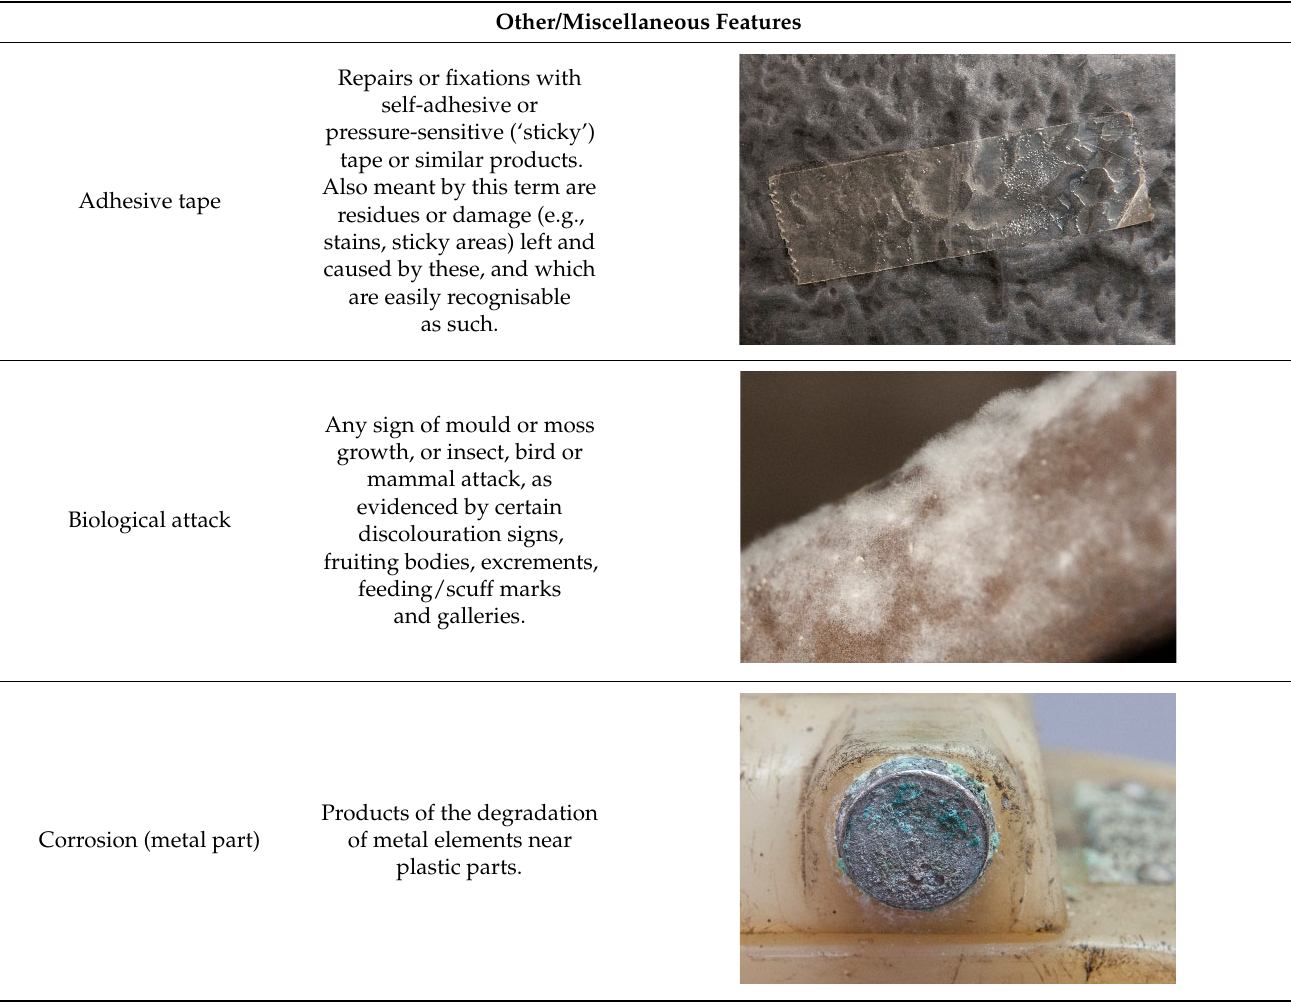
Table 8. Definitions of the category ‘other/miscellaneous features’.